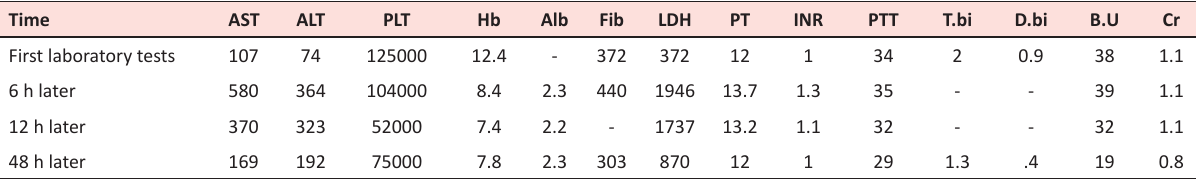
Table 1. Laboratory